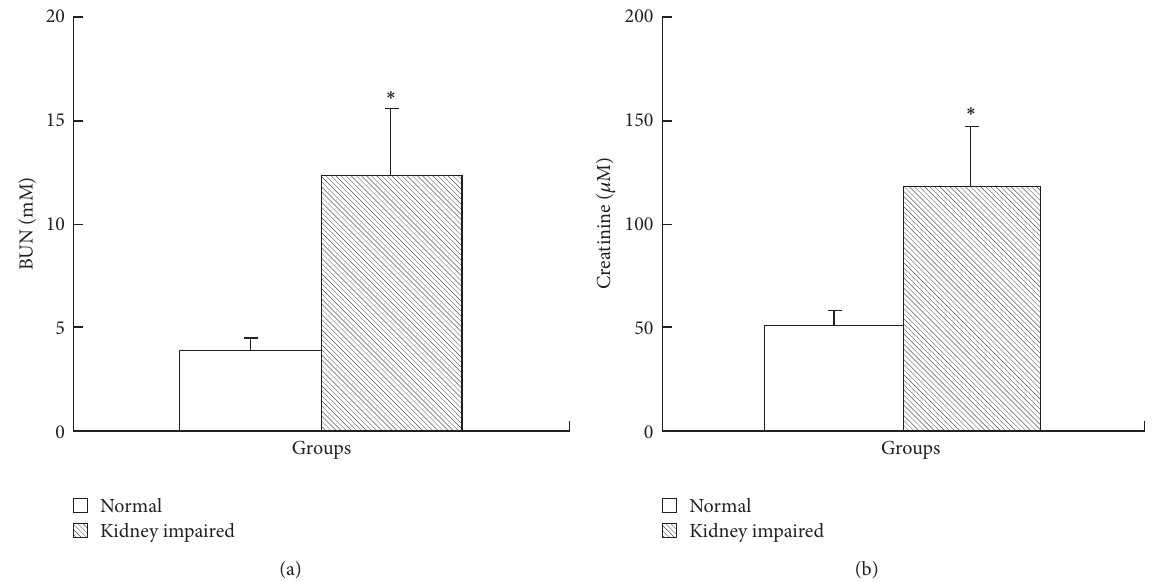
Figure 1: Rat renal function assay (mean ± SD, 𝑛 = 10 ). Intragastric administration of adenine was able to cause renal function damage. The BUN in kidney impaired group (a) was 12.33 ± 3.27 mM, much higher than that ( 3.87 ± 0.62 mM) in normal group ( 𝑃 < 0.05 ), and the creatinine in kidney impaired group (b) was 118.25 ± 28.63 𝜇 M, also much higher than that ( 51.48 ± 6.98 𝜇 M) in normal group ( 𝑃 < 0.05 ). Rats in kidney impaired group were intragastrically treated with adenine (400mg/kg × 5 days), while those in normal group were treated with normal saline of the same volume. ∗ versus normal group, 𝑃 < 0.05 , Student’s 𝑡 -test.